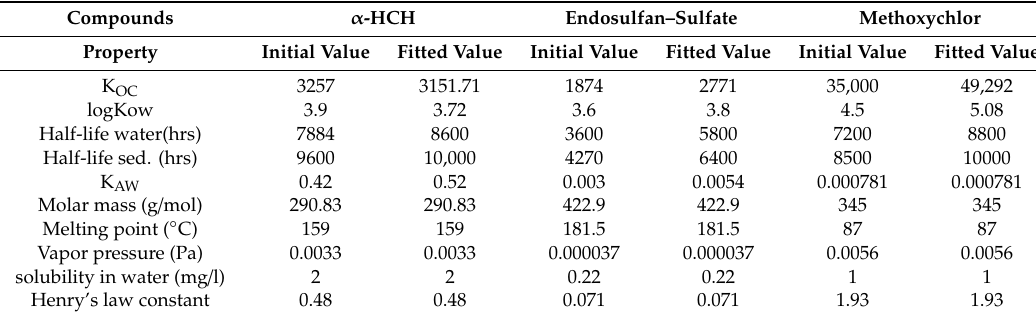
Table 1. Physicochemical properties of the pesticides used in the model calibration.